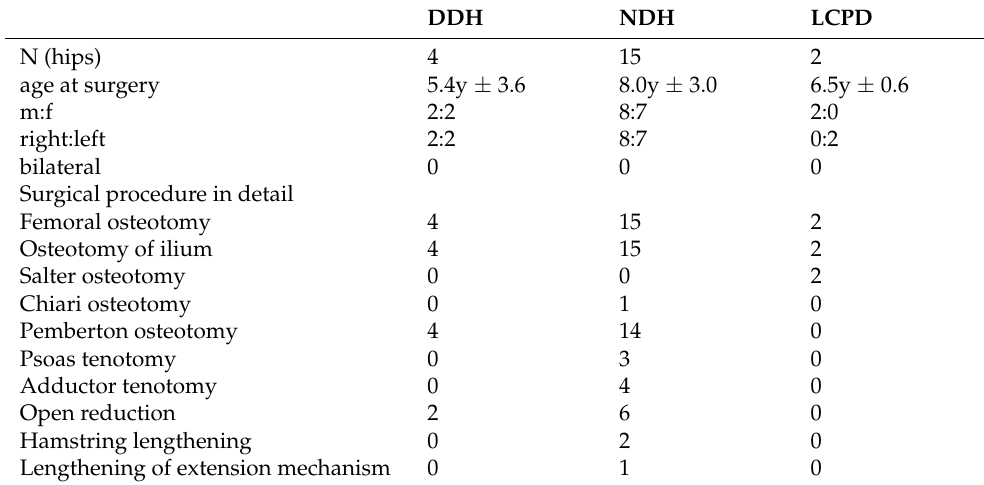
Table 2. Epidemiologic data and procedures.